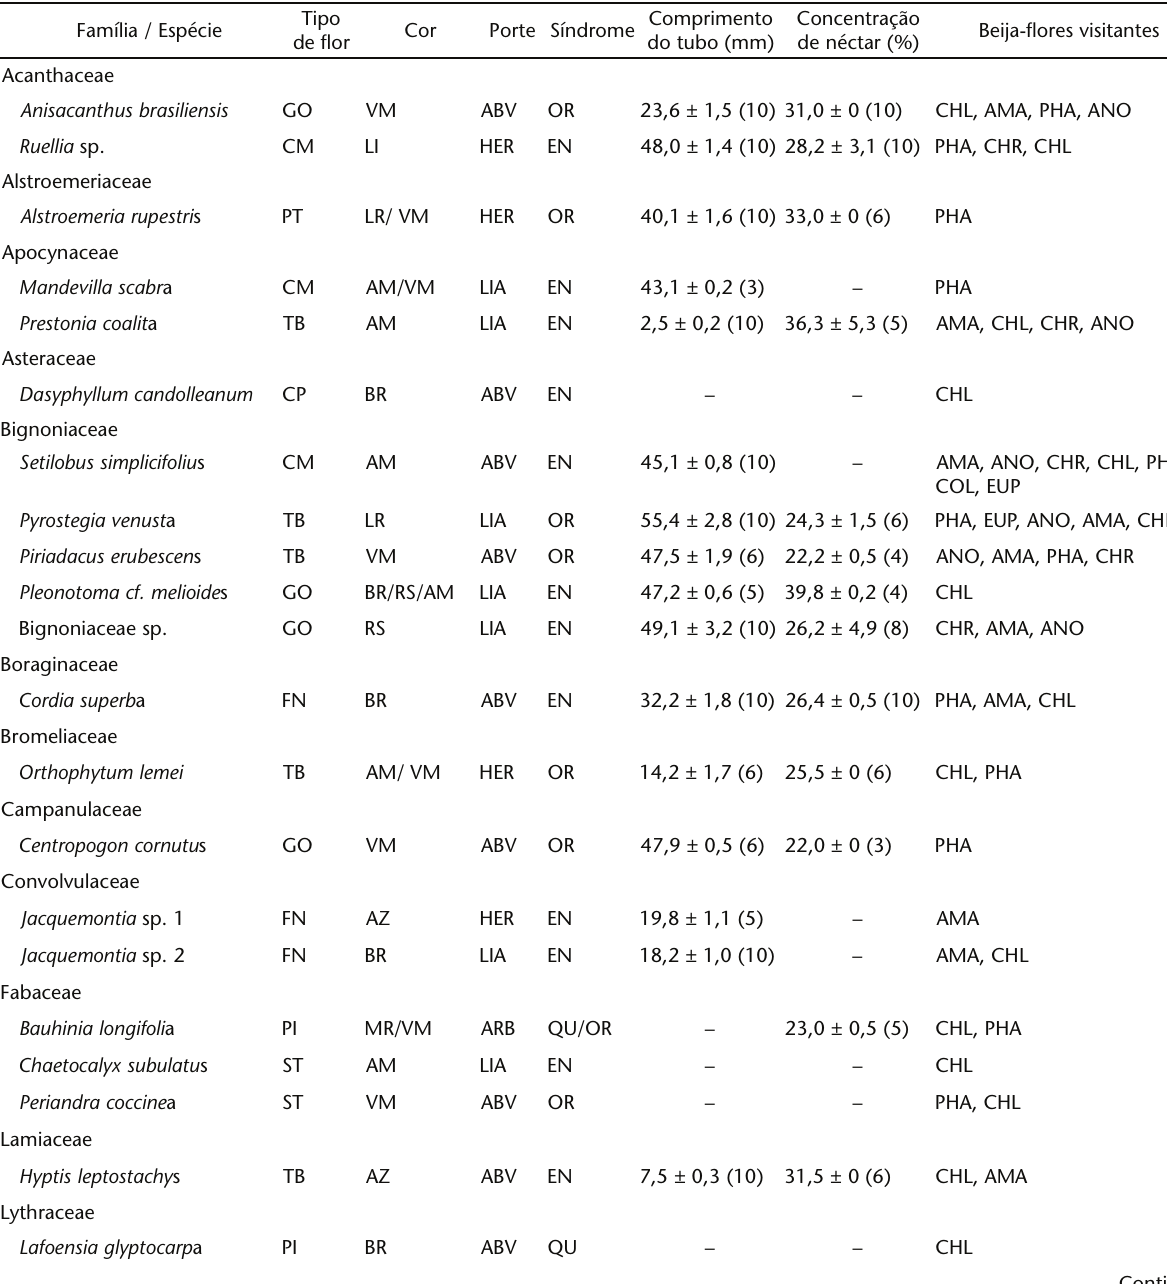
Tabela II. Espécies de plantas visitadas por beija-flores em uma área de caatinga arbórea da Chapada Diamantina, no município de Mucugê, Bahia, de outubro de 2005 a agosto de 2007. Tipo de flor: (TB) tubo, (PT) pseudo-tubo, (GO) goela, (CM) campânula, (FU) funil, (PI) pincel, (DI) disco, (CP) capítulo, (ST) estandarte. Cor da flor: (VM) vermelha, (AM) amarela, (BR) branca, (LI) lilás, (LR) laranja, (RS) rosa, (AZ) azul, (MR) marrom. Porte: (ABV) arbustivo, (HER) herbáceo, (ARB) arbóreo/subarbóreo, (LIA) liana. Síndrome -